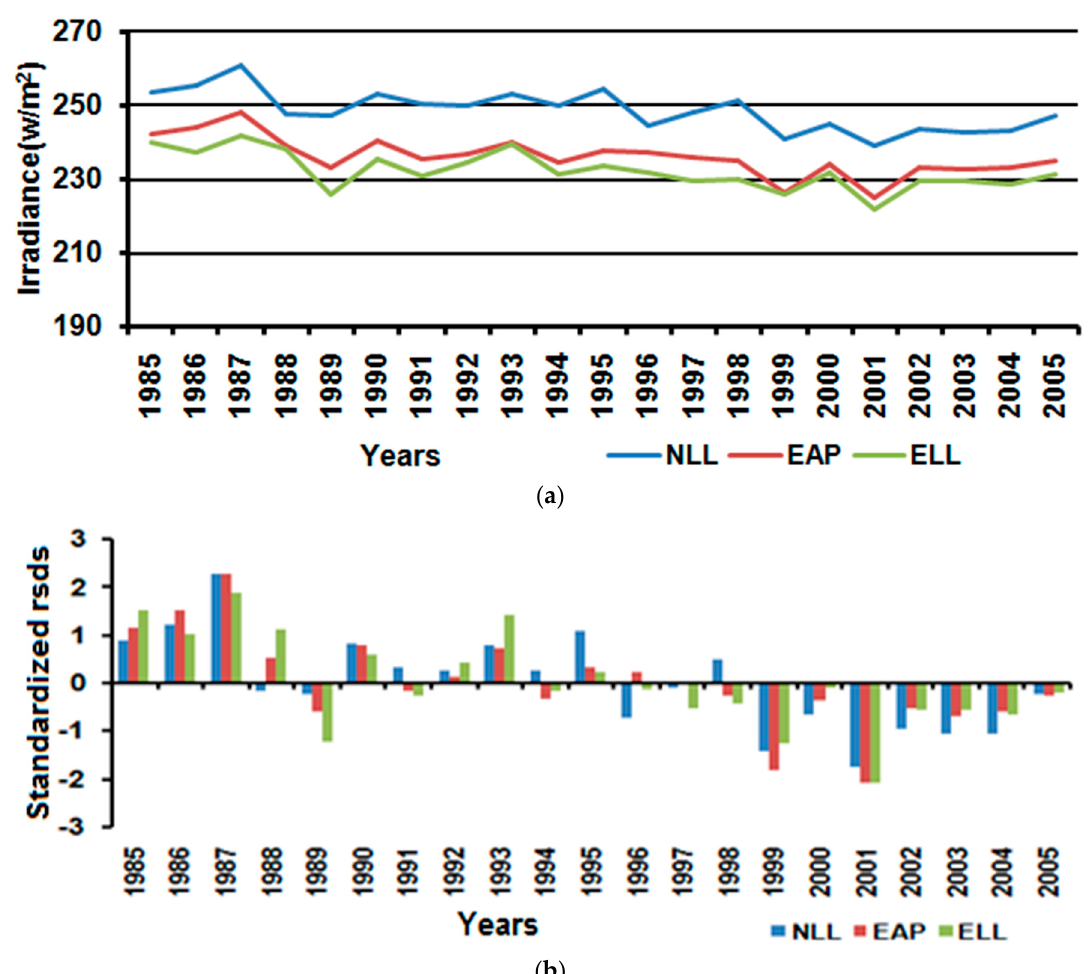
Figure 5. Interannual ( a ) solar irradiance patterns; ( b ) standardized solar irradiance at NLL, EAP, and ELL over the period 1985–2005.